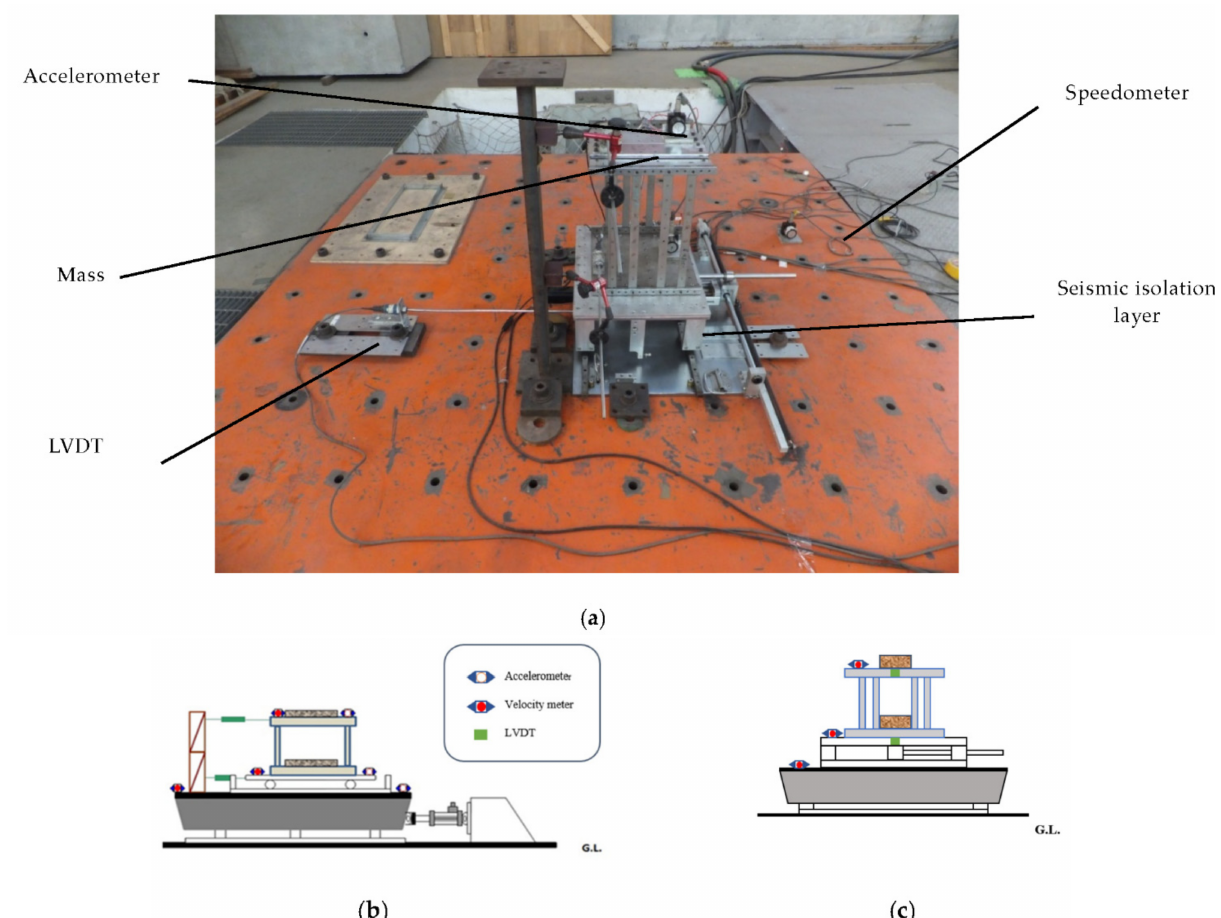
Figure 6. Experimental setup and the instrumentation configuration. ( a ) Assembling of the isolation layer and superstructure. ( b ) Side view of the instrumentation. ( c ) Front view of the